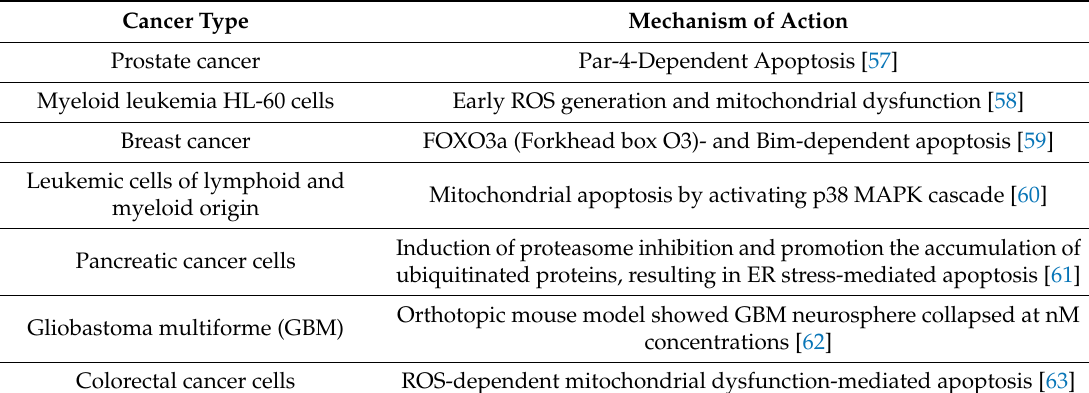
Table 3. Withaferin A (WFA), its role in cancer with the mechanism of